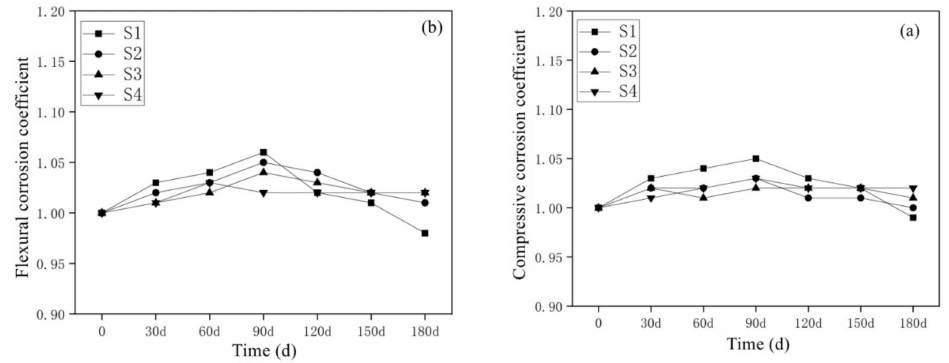
Figure 10. Compressive ( a ) and flexural ( b ) corrosion resistance coefficients of MSWI mortars under sodium chloride semi-immersion